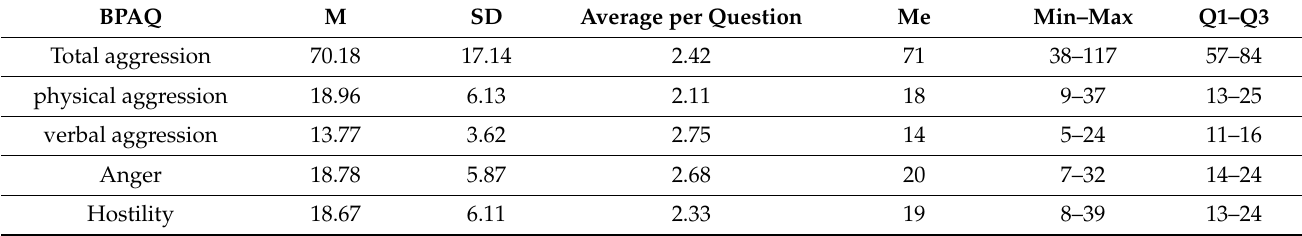
Table 2. Aggression according to